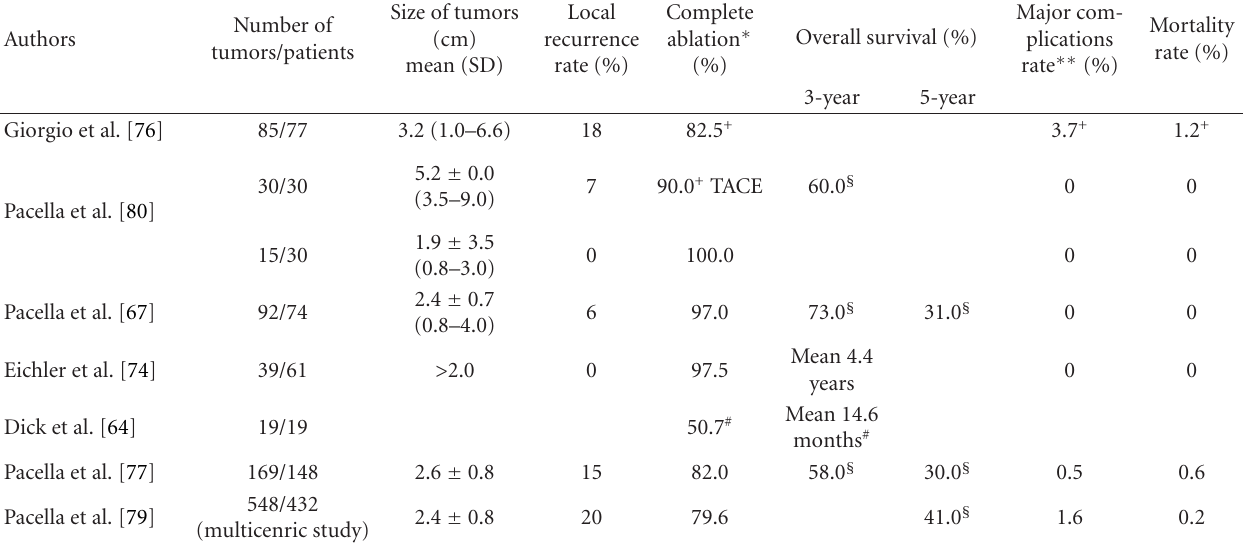
Table 1: Studies reporting the outcome of Laser Ablation for small hepatocellular